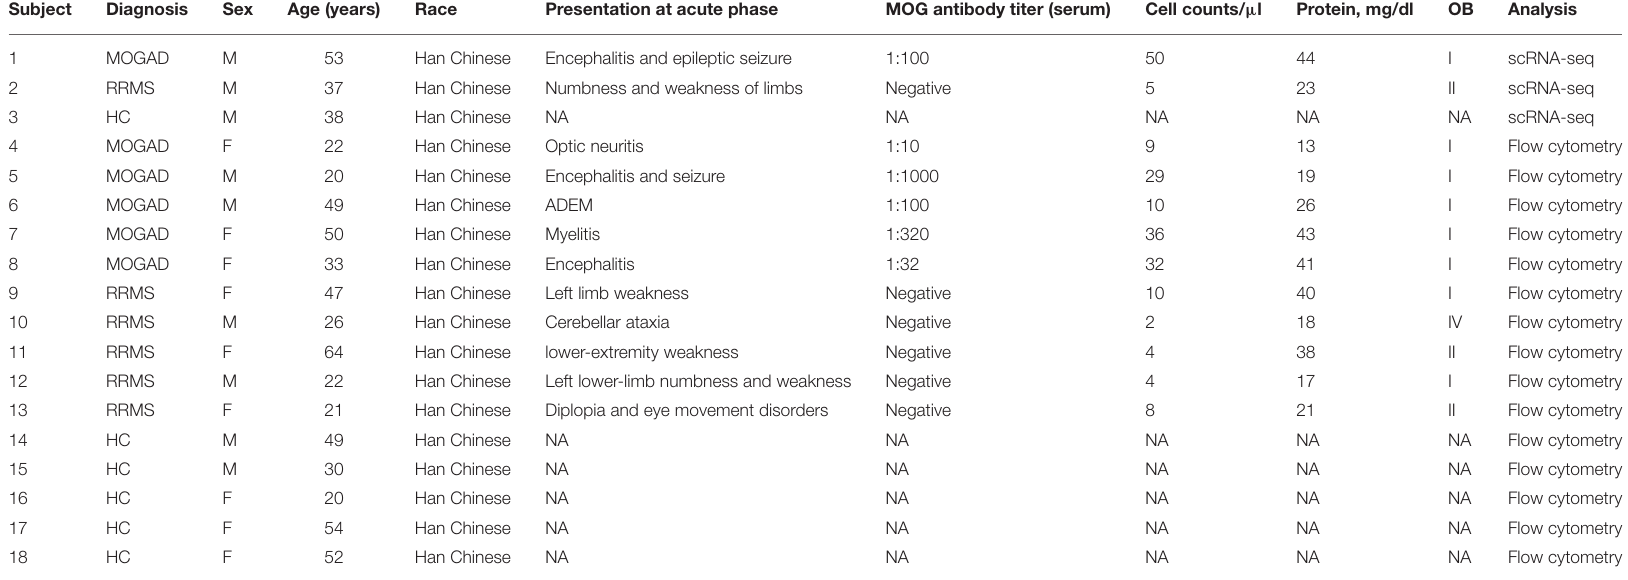
TABLE 1 | Demographic and clinical features of subjects.